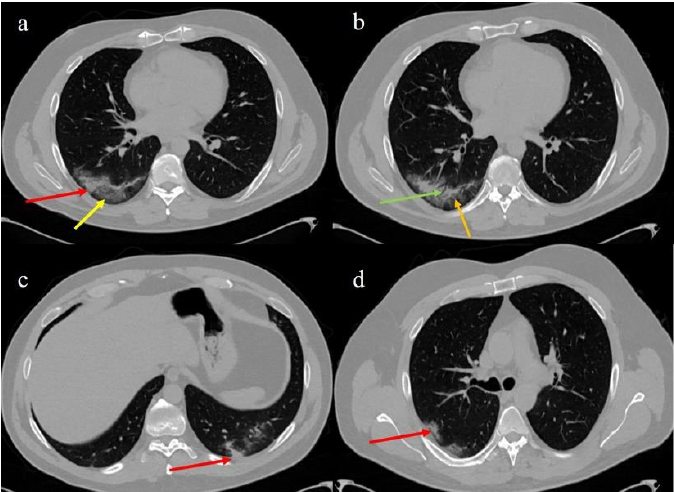
Figure 1. Chest computed tomography (CT) images of the patient with the typical distribution of COVID-19 pneumonia: ( a ) consolidation (red arrow) and crazy paving area (yellow arrow) with a posterior and peripheral distribution in the right inferior lobe; ( b ) observed air bronchogram (green arrow) in the consolidation together with small vascular vessel enlargement (orange arrow); ( c ) small consolidations in the left inferior lobe (red arrow); ( d ) small consolidations in the posterior segment of the right superior lobe (red arrow).